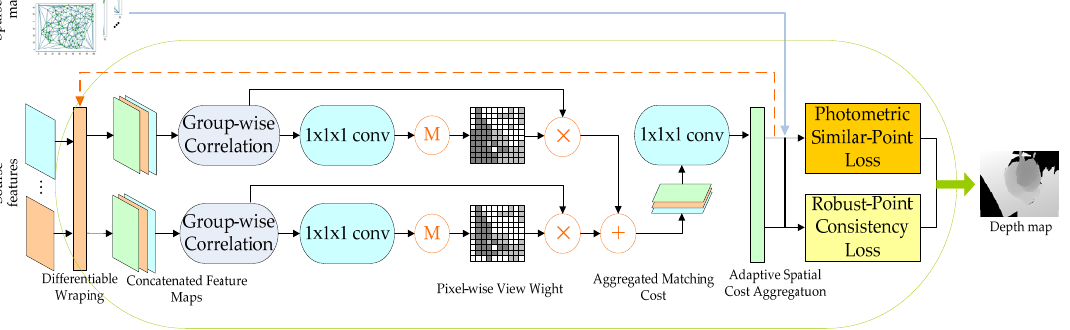
Figure 2. A subnetwork SparsePatchMatch. Our main contribution is to process subsequent depth maps for semi‑supervised testing with photometric similar‑point loss and robust‑point consistency loss.